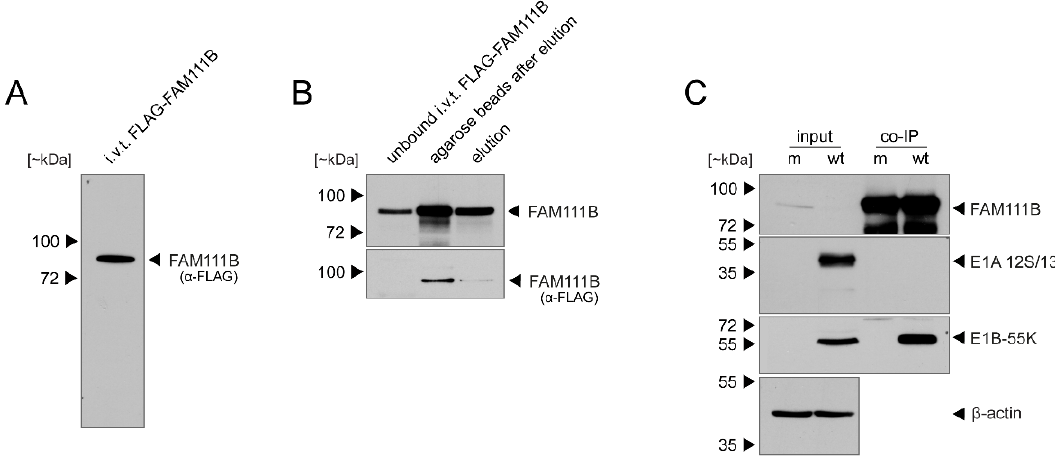
Figure 2. In vitro-translated FAM111B interacts with E1B-55K. ( A ) FLAG-tagged FAM111B was produced by in vitro transcription/translation (i.v.t.) with wheat germ extract. ( B ) Samples were coupled with anti-FLAG M2 affinity gels. ( C ) Subconfluent A549 cells were infected with wt HAdV-C5 (MOI 5) and total cell lysates were prepared at 48 h p.i. and incubated with FLAG-tagged FAM111B beads. Input cell lysates and FAM111B co-immunoprecipitated proteins were resolved by SDS-PAGE and visualized by immunoblotting. Proteins were detected using pAb HPA038637 ( α -FAM111B), mAb M73 ( α -E1A), mAb 2A6 ( α -E1B-55K) and mAb AC-15 ( β -actin). Molecular masses in kilodaltons (kDa) are indicated on the left and corresponding proteins are indicated on the